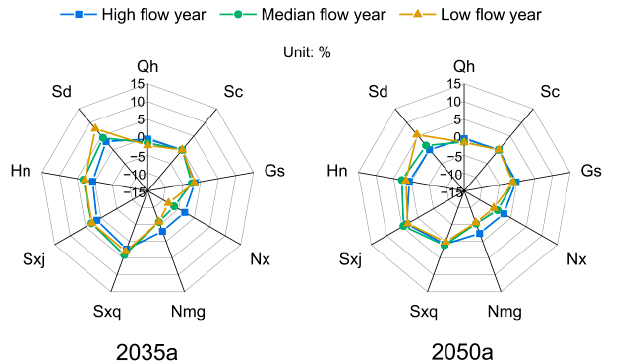
Figure 10. Difference rate between the water resource allocation scheme and water demand expected in the Yellow River Basin in 2035a and 2050a.